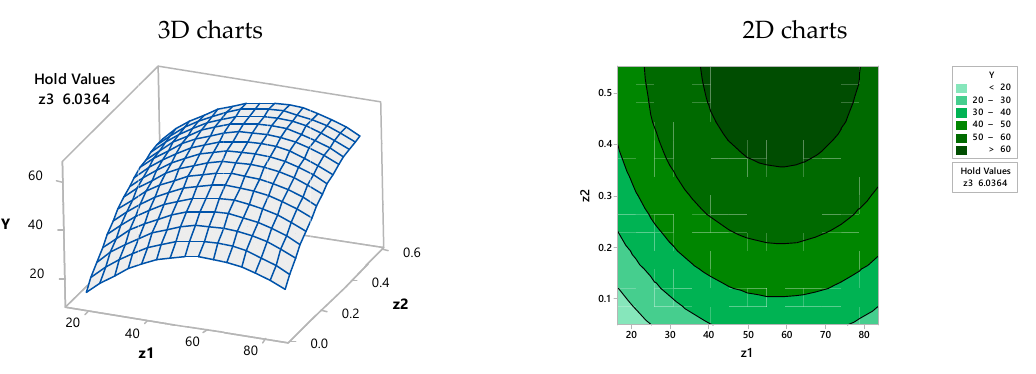
Figure 3. Surface plot ( left ) and contour plot ( right )—efficiency (Y) vs. biosorbent concentration (Z 1 ) and BRed dye concentration (Z 2 ) at a constant biosorption contact time (Z 3 = 6.0364 h).